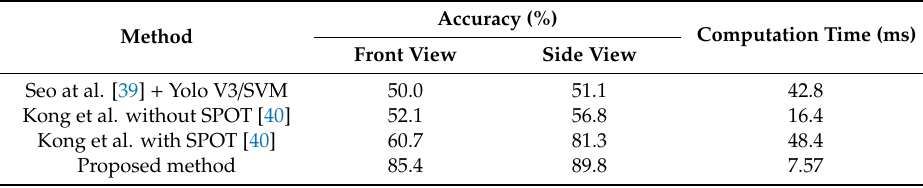
Table 10. The comparison with taekwondo action recognition